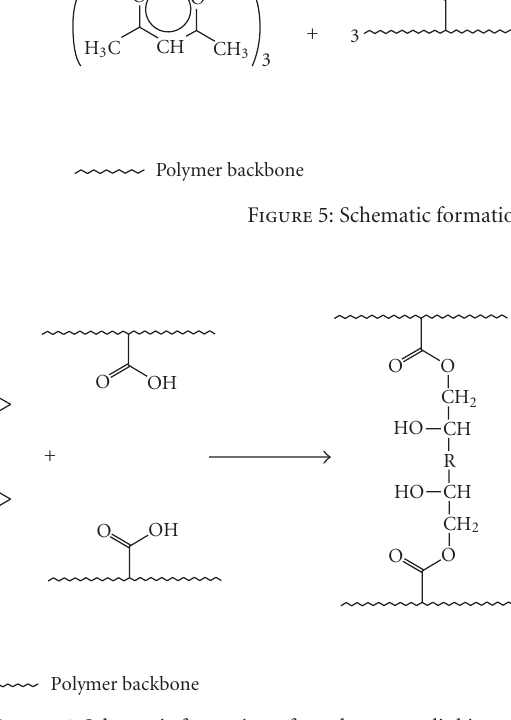
Figure 6: Schematic formation of covalent